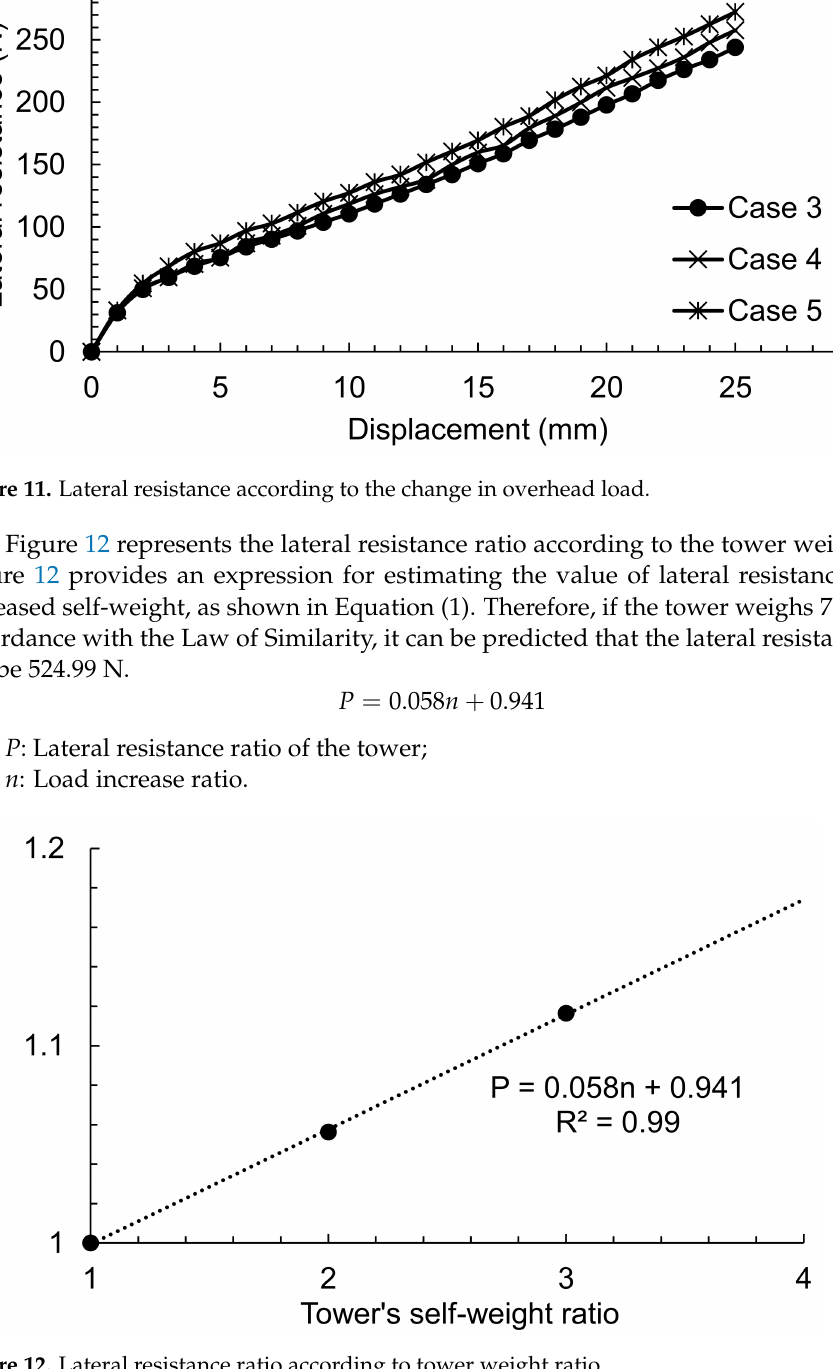
Figure 12. Lateral resistance ratio according to tower weight